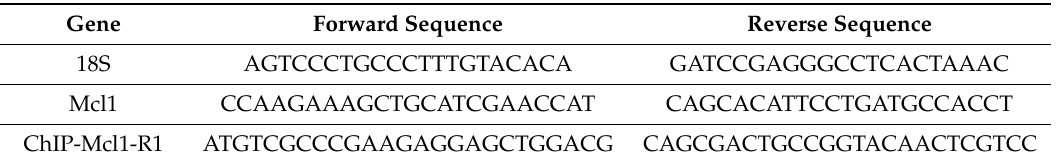
Table 1. Primers for real-time